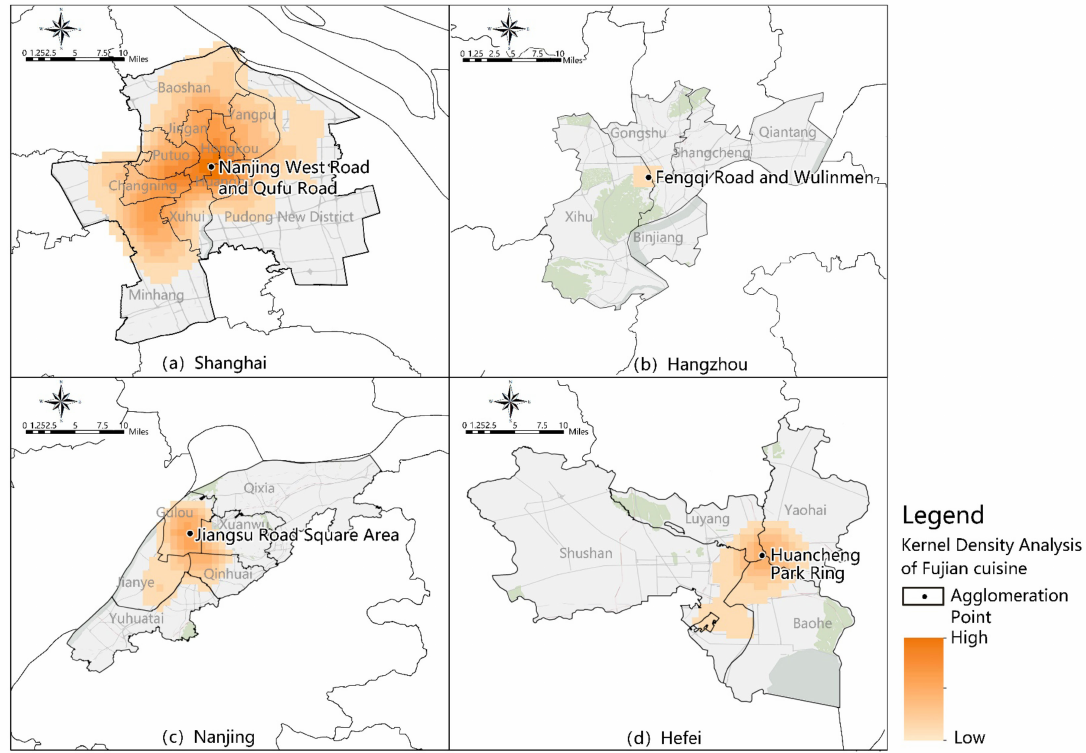
Figure 11. Kernel density analysis of Fujian cuisine in the main urban areas of the four central cities in the